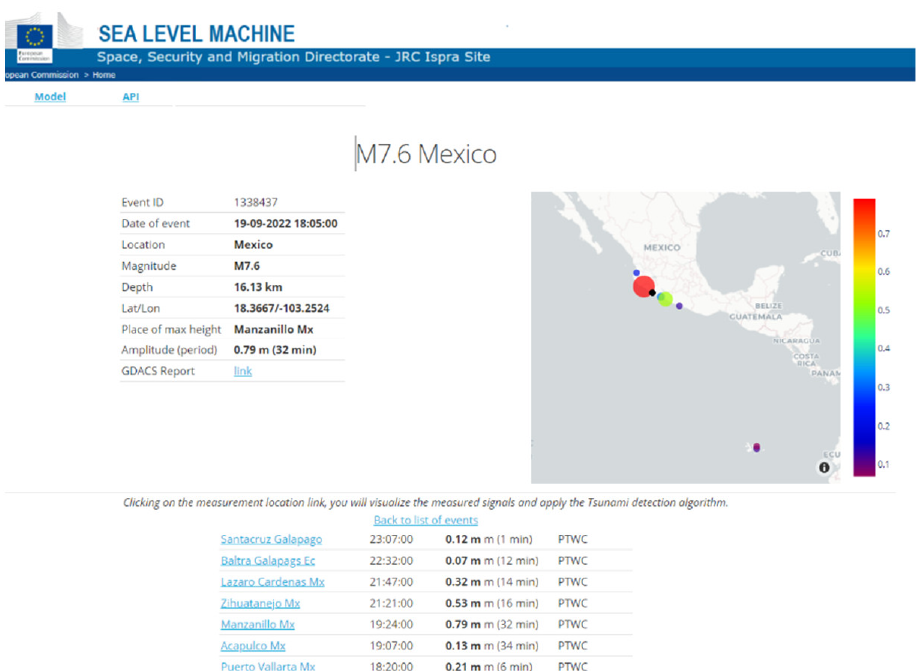
Figure A2. Screenshot of the SLM web site with the list of available measurements for one particular event.